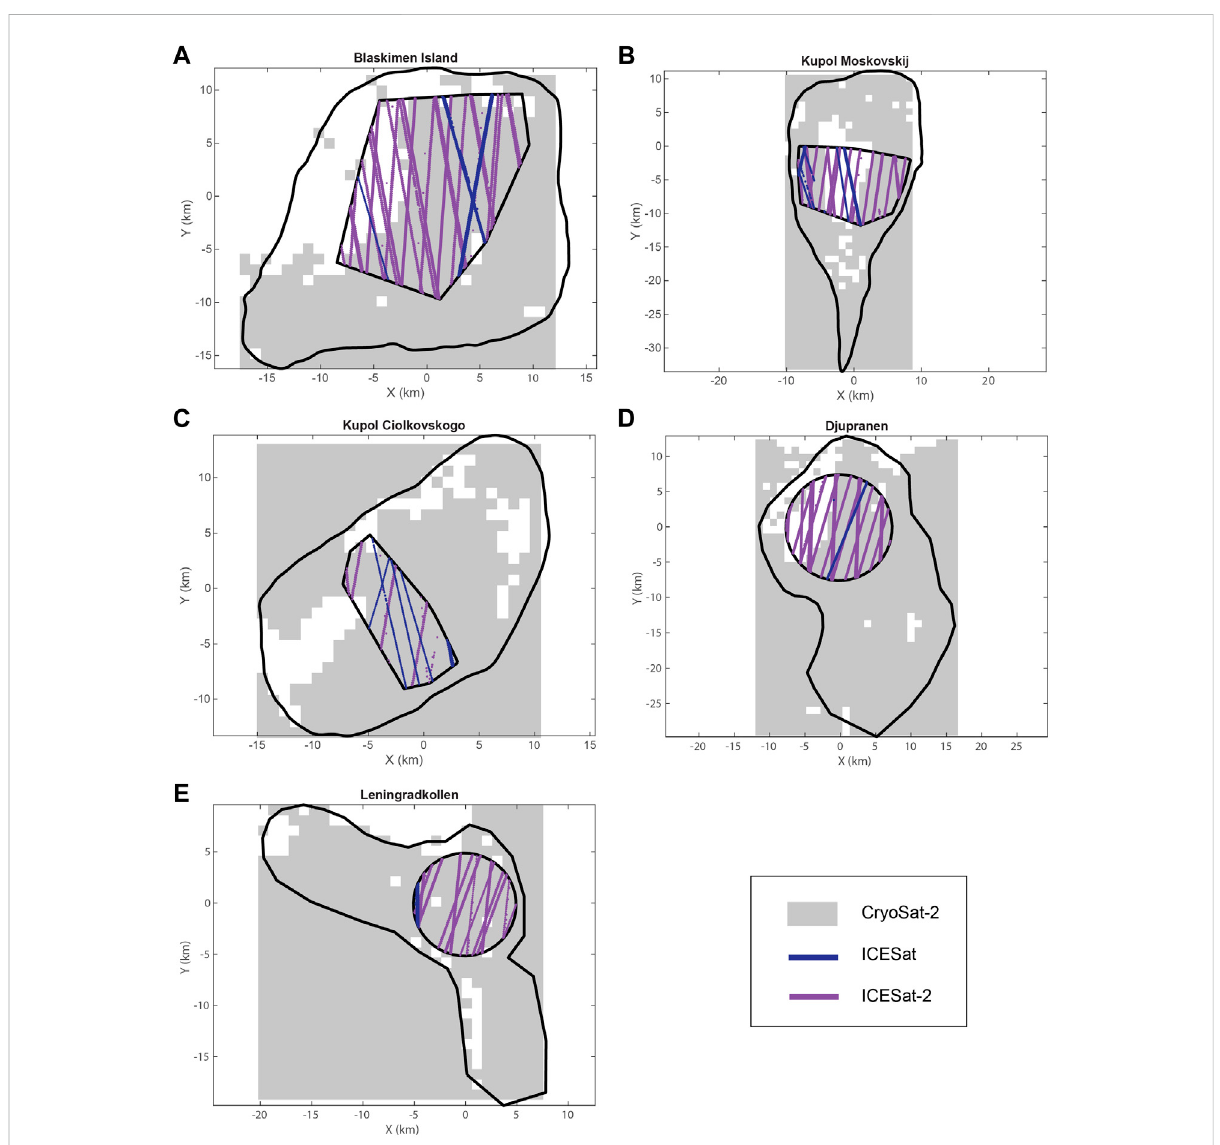
FIGURE 4 Altimetry data coverage over ice rises. Blåskimen Island (A) , Kupol Moskovskij (B) , Kupol Ciolkovskogo (C) , Djupranen (D) and Leningradkollen (E) .CoverageofICESat(blue),ICESat-2(Purple),andCryoSat-2gridafterremovingnoisyandlowcon fi dencedata.Inthisstudy,weonlyconsiderthe data inside each of the polygons (and circles) used for mass balance estimation. These altimetry data are summarized in Supplementary Figures S1 –